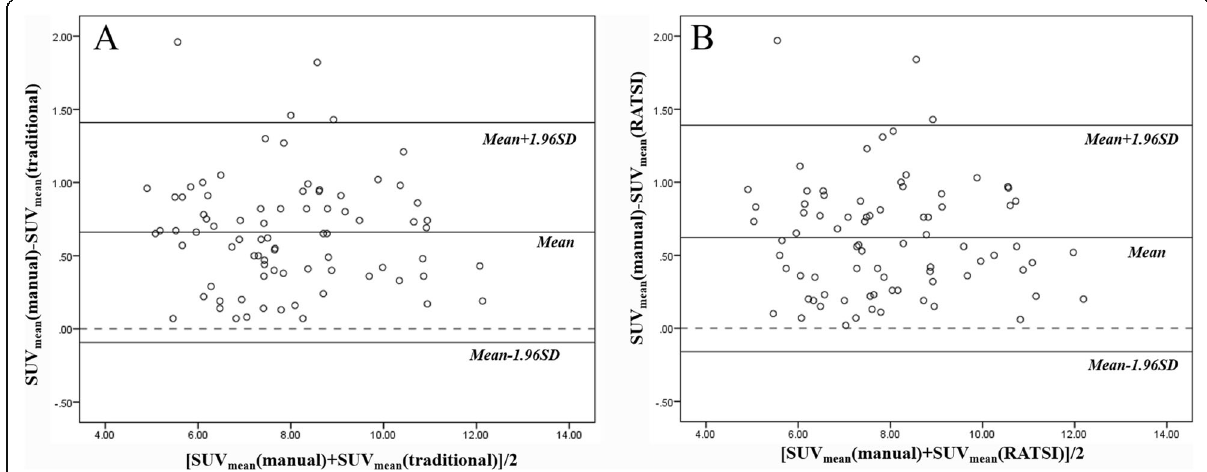
Fig. 6 Bland – Altman graphs to evaluate the SUV mean consistency of the RSIAT method ( a ) and RATSI ( b ) in comparison with the manual segmentation in the four representative regions including the left, right caudate nucleus, and putamen. The SD represents the standard deviation